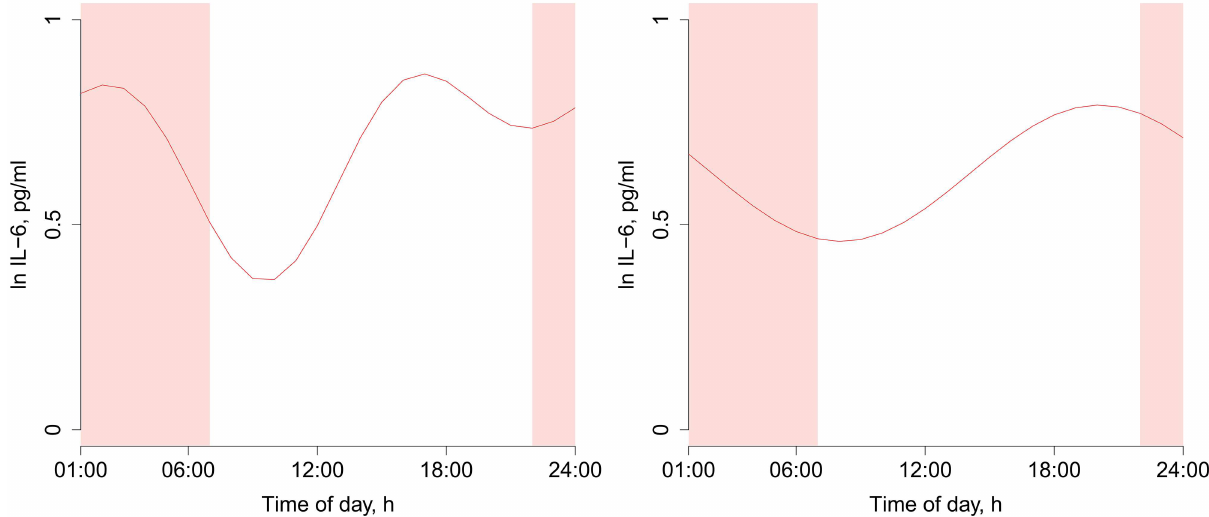
Fig 4. Predicted diurnal time courses from meta-regression models. Left: Best-fitting model includingcosinor functionswith 24 and 12 h periods. Right: Model including only 24 h period. Time from 22:00 to 07:00 is shadedto indicate the night.